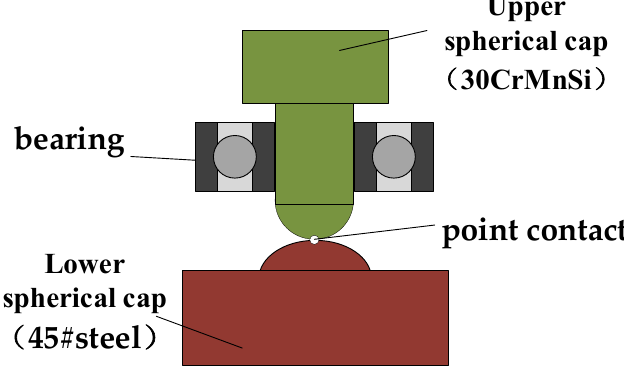
Figure 4. The point contact spherical cap